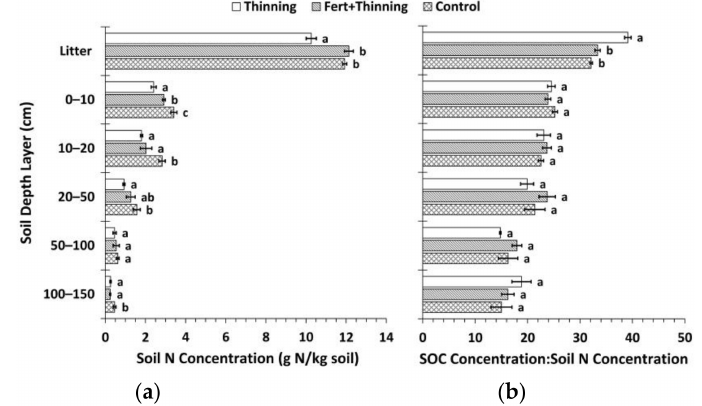
Figure 4. ( a ) Mean soil nitrogen (N) concentration by treatment; ( b ) mean soil organic carbon (SOC) concentration to N concentration by treatment. Sample size for all treatments and soil depth layers is three. Error bars represent ± one standard error. Means within each soil depth layer accompanied by the same letter (i.e., “a” or “b”) are not significantly different (Tukey’s HSD, α = 0.1). Fert, fertilized.